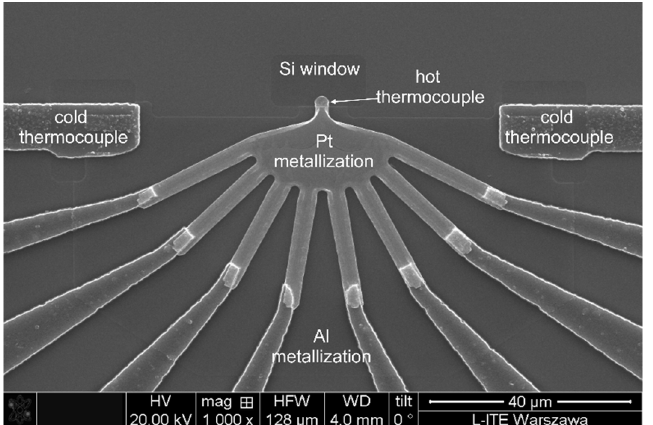
Figure 2. SEM image of the thermometric structure (before FIB processing) showing the layout of cold (reference) and hot thermocouples.